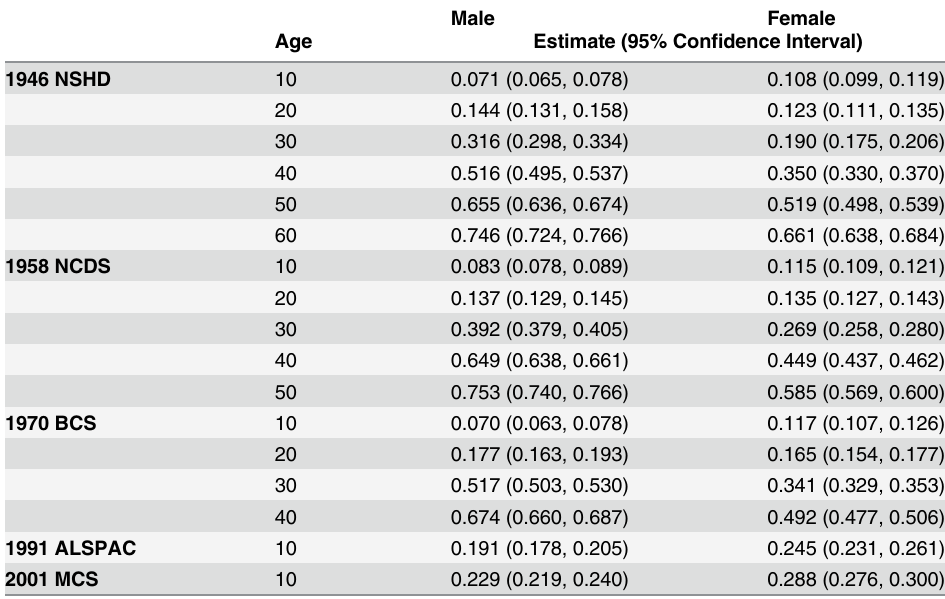
Table 2. Estimated probabilities of overweight or obesity (versus normal weight) from sex- and study- stratified multilevel logistic regression models.